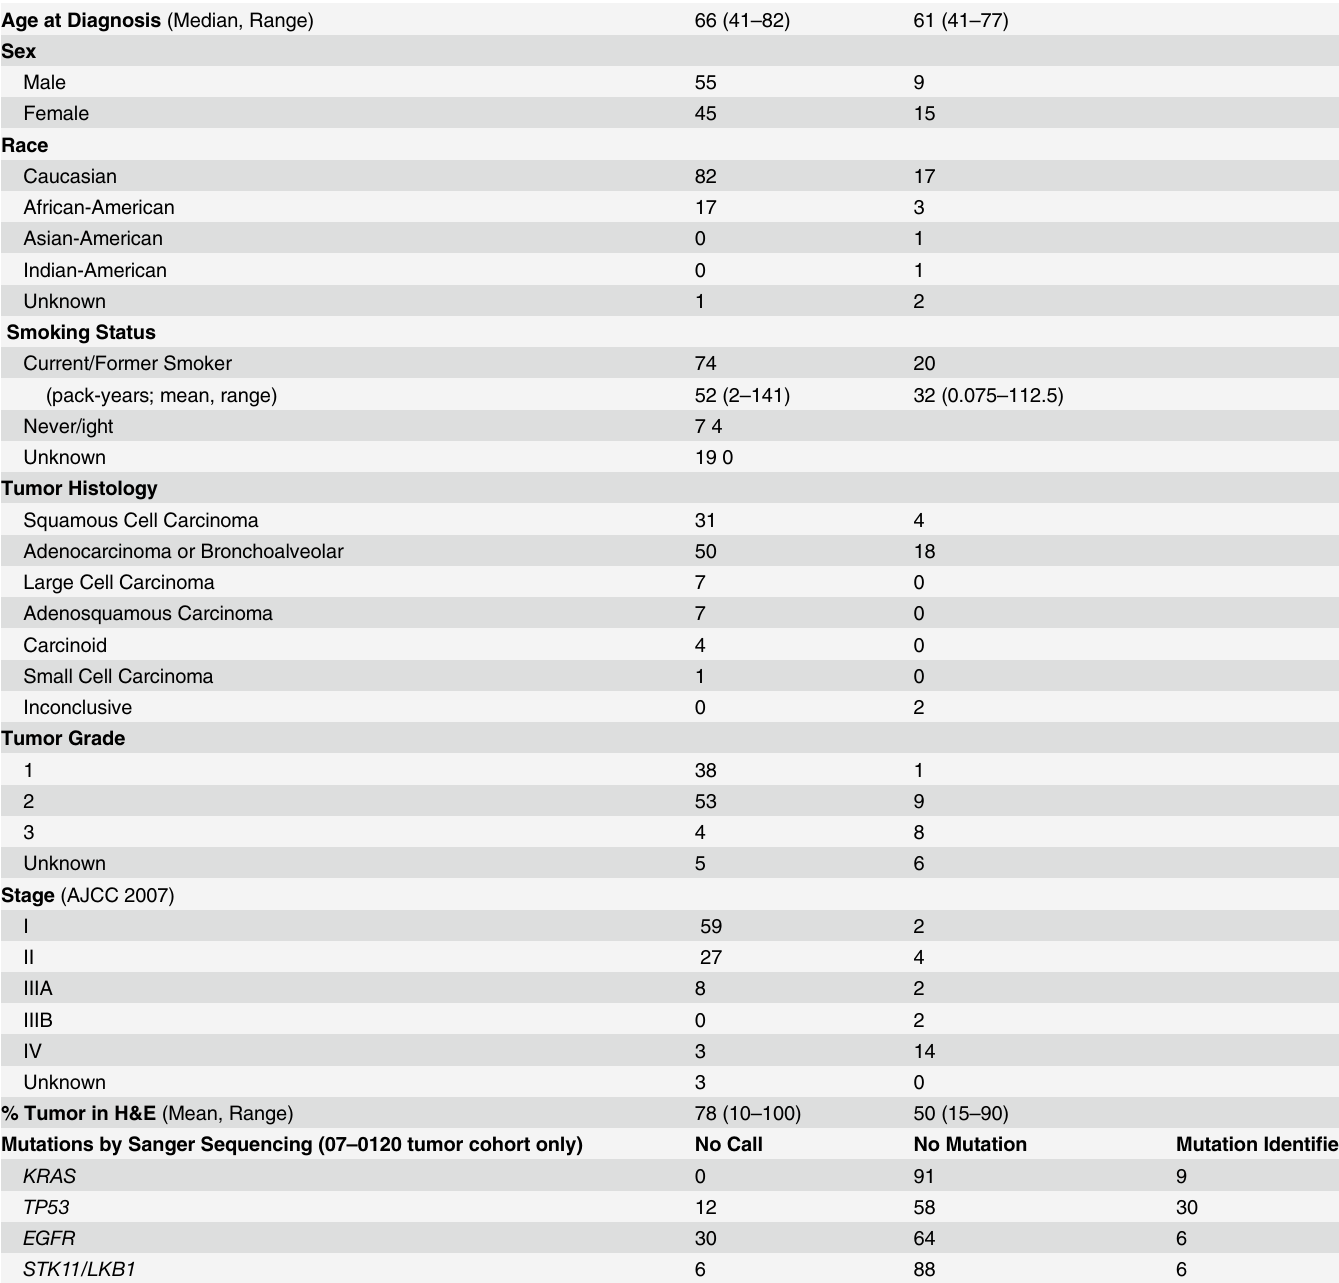
Table 1. Clinicopathologic characteristics of lung cancer specimens for the 07 – 0120 and 11 – 1115 tumor tissue cohorts. Age at Diagnosis (Median,